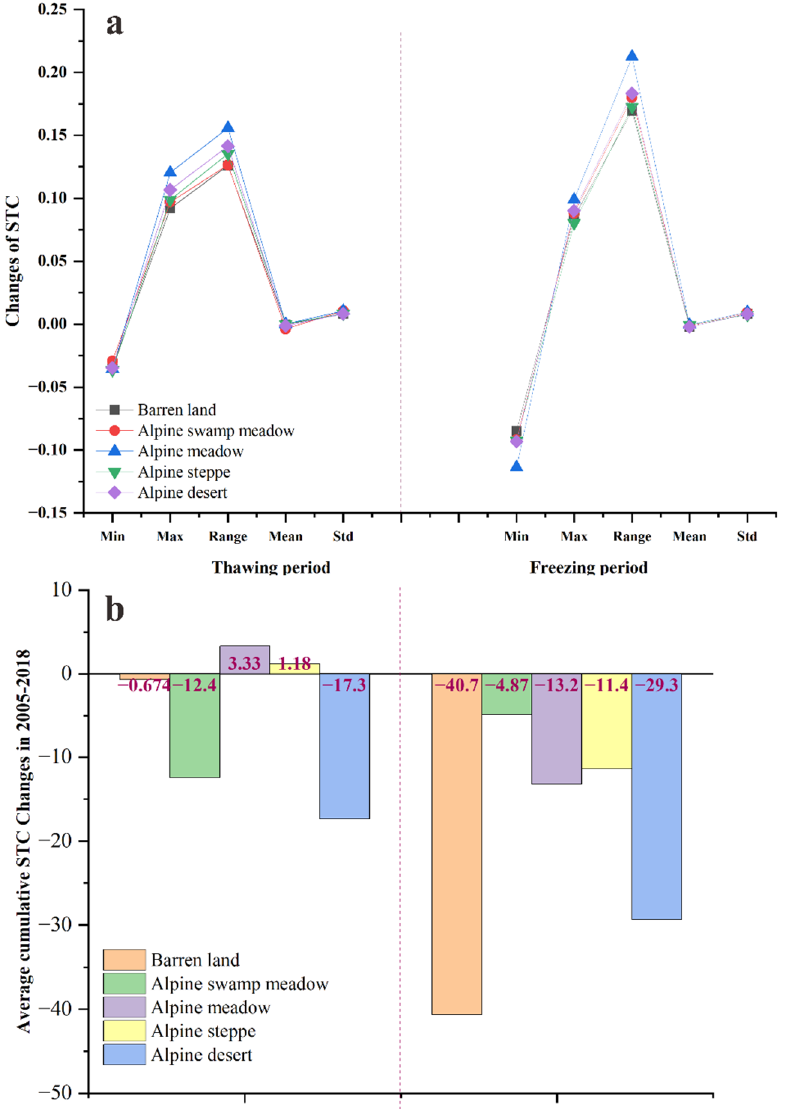
Figure 15. Interannual variation ( a ) and cumulative variation ( b ) of STC in different underlying surface types from 2005 to 2018.